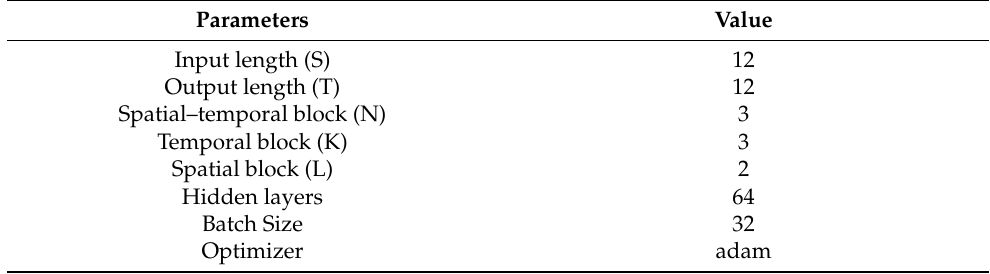
Table 2. The details of the parameter